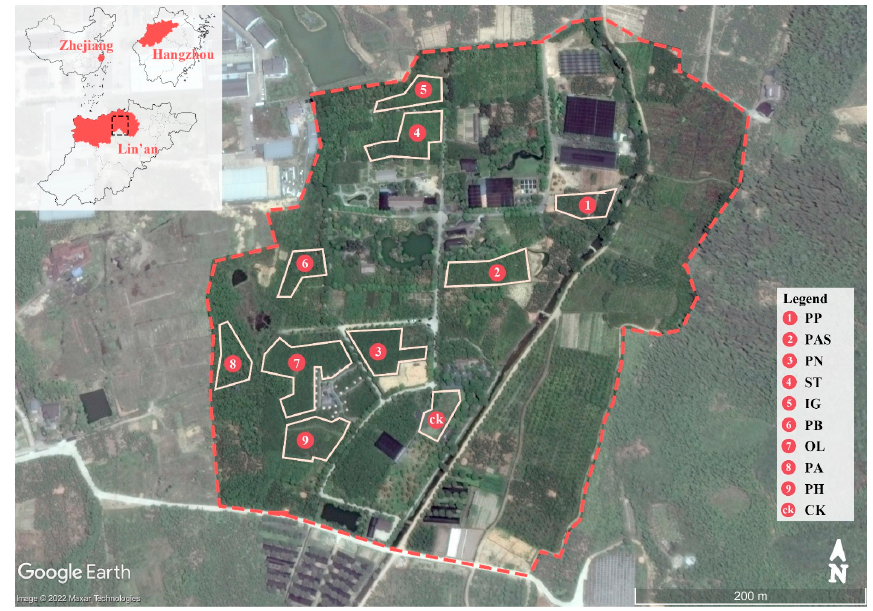
Figure 1. Map of the study area and measurement sites. Table 1. Morphological indicators, canopy structure data, and photos of bamboo communities. AH: average height (m); DBH: diameter at breast height (cm); PD: planting density (T·m − 2 ), T: tree; LAI: leaf area index; CC: canopy coverage (%); SVF: sky view factor (%).